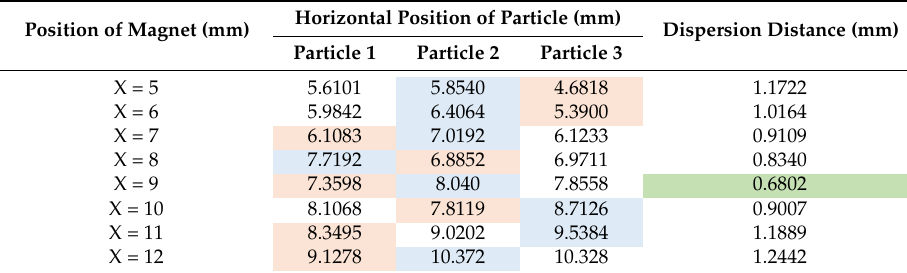
Figure 15. The position of magnet versus the required size of outlet: as the magnet moves in horizontal position far away from inlet particle, dispersion decreases and reaches a minimum value above this extreme point further moving of magnet increases the distance between particles hitting the bottom wall. Table 2. This table contains magnet location and the position of particles representative of particles flowing the top middle and bottom of inlet channel; as can be observed, there exists a point at which the distance between particles is